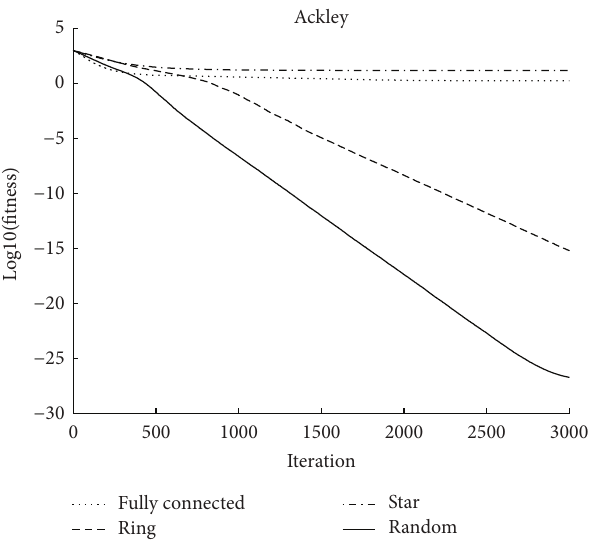
Figure 4: Comparison of evolutionary trend between four topolo- gies